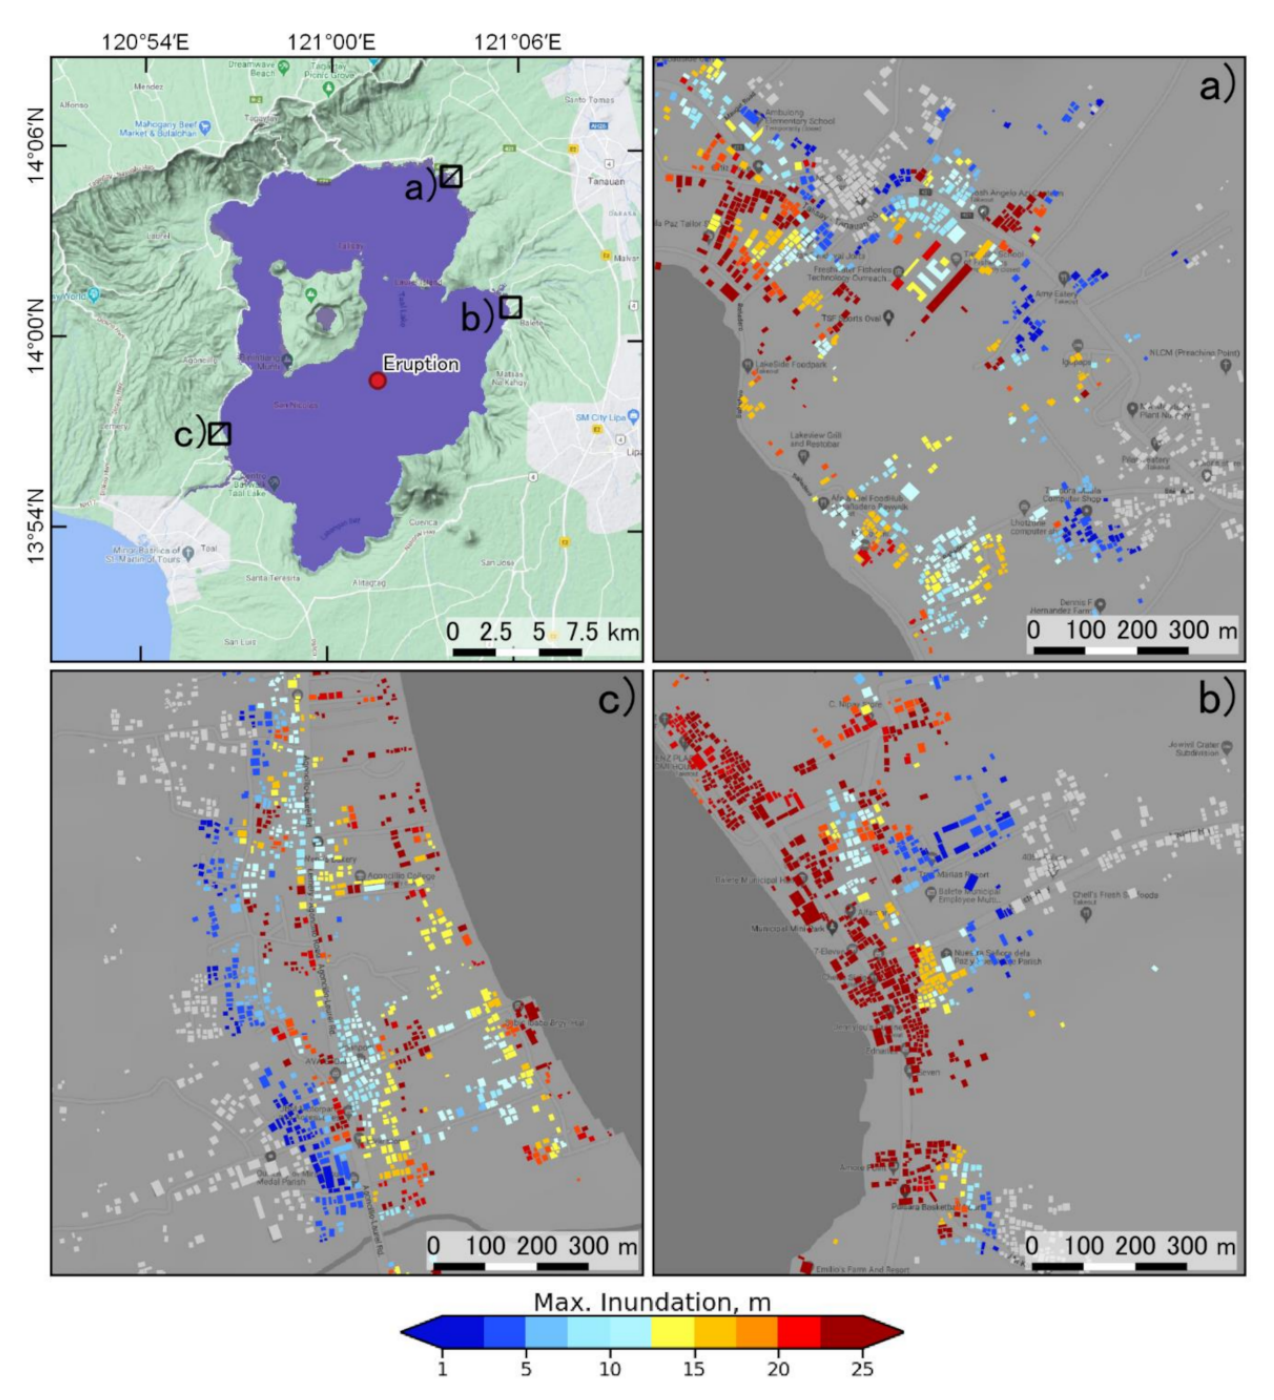
Figure 8. Tsunami hazard map showing the maximum inundation depths for the buildings with a probability of 1/1000 in some example areas. ( a ) northern coastal area, ( b ) coastal area near to the eruption point, and ( c ) southern coastal